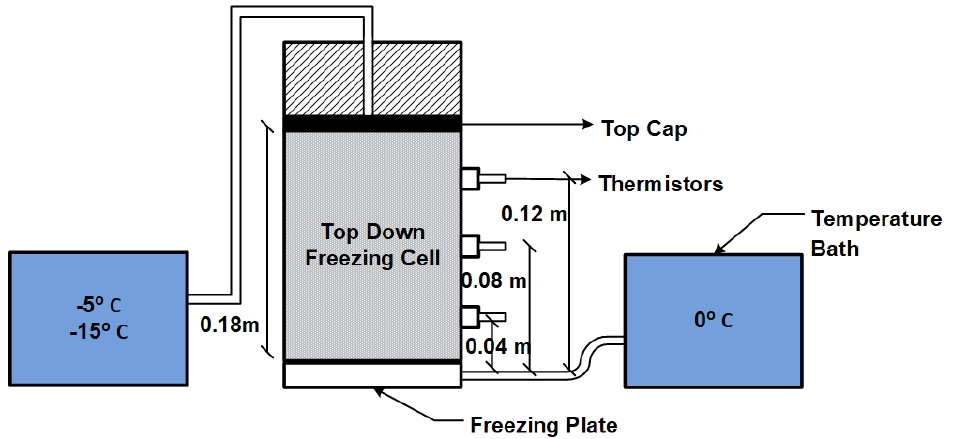
Figure 2. Schematic diagram of the freeze–thaw test setup (after [9,16]). For the drying–wetting cycles, the drying tests were carried out in the freezing cells at room temperature (~20 ◦ C) under which the weight loss due to evaporation was recorded daily along with the subsequent shear strength measurements. The volume of water that evaporated during each drying cycle was poured back into the cells to simulate the rainfall/wetting